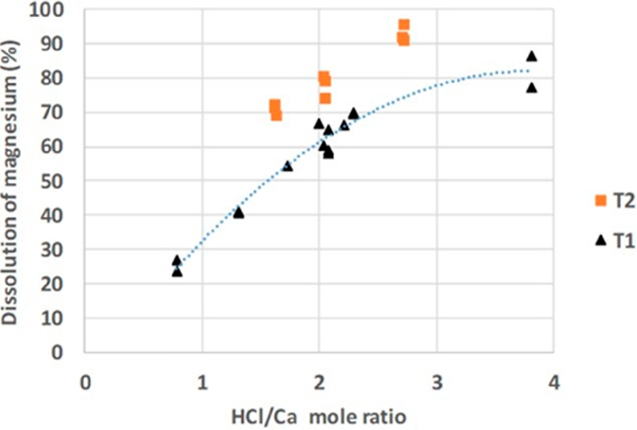
Figure 3. Dissolution of Mg depending on HCl dosage where T1—Toolse 1, T2—Toolse 2.